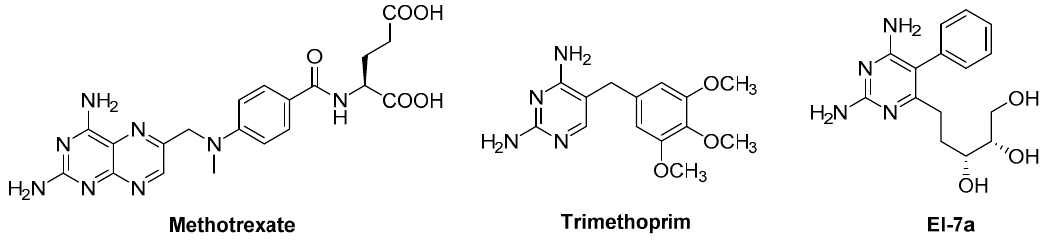
Figure 1. The structures of “classical” and “non-classical” DHFR inhibitors.